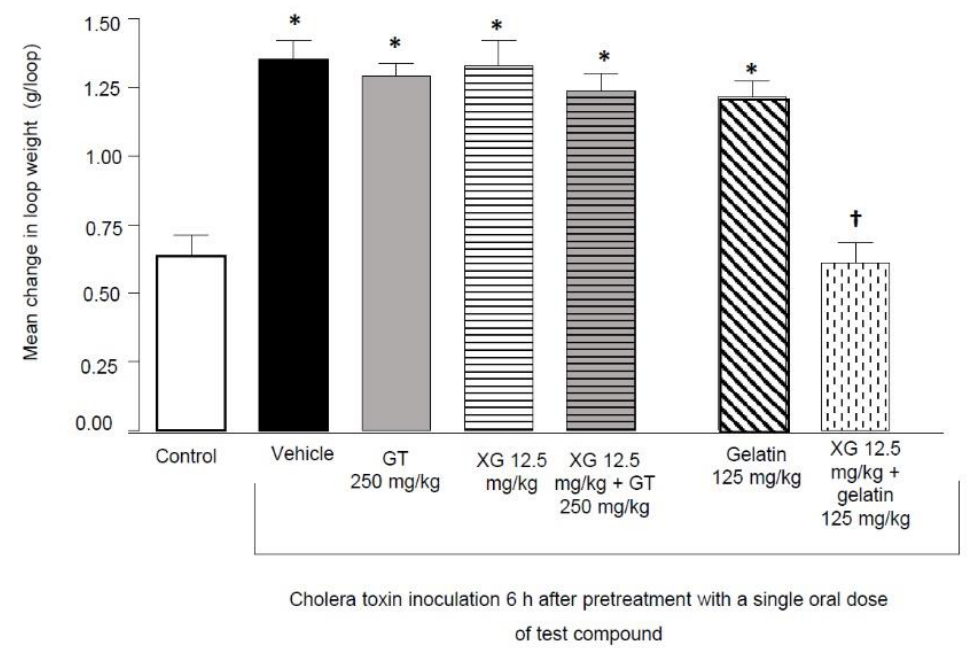
Figure 4. Pretreatment with single-dose oral xyloglucan 12.5 mg + gelatin 125 mg/kg 6 h before cholera toxin (CT) inoculation significantly attenuated CT-induced intra-loop water secretion relative to vehicle in isolated jejunal loops of anesthetized rats ( n = 8/group). * p < 0.05 vs. control, † p < 0.05 vs. vehicle.